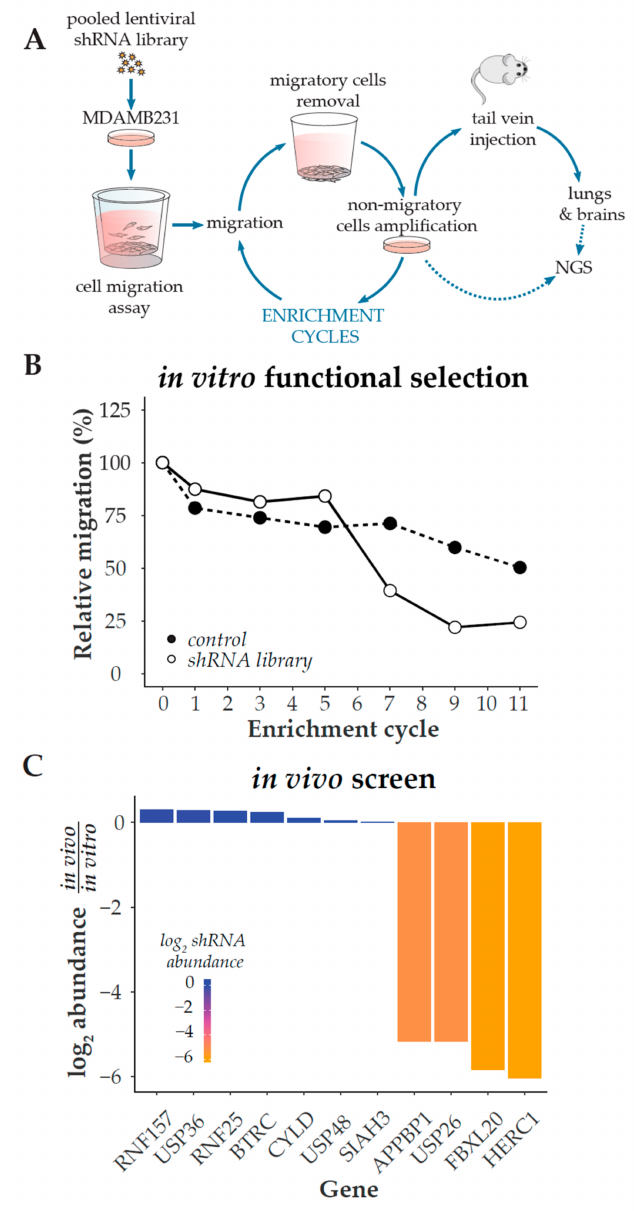
Figure 1. shRNA-based selection of positive regulators of cell migration. ( A ) Overview of the selection procedure. The production and infection of an ubiquitylation-related lentiviral shRNA library are described in Methods. Two weeks after lentiviral infection and selection, MDA-MB-231 cells were seeded onto Boyden chamber inserts and allowed to migrate across the porous membrane at 37 ◦ C for 24 h in order to select cells with a decreased migration phenotype. Migrating cells were removed and non-migrating cells were collected by trypsin treatment from the inserts upper compartment and cultivated for one week. Cells were then reseeded onto Boyden chamber culture inserts for a subsequent round of selection; this procedure was repeated until cells lost 75% of their initial migratory potential. This non-migratory population of cells was then inoculated through tail vein injection into NOD/SCID mice, and primary cultures were generated after two months from lung and brain tissues. shRNAs were retrieved by PCR from the in vitro and in vitro/vivo-selected cells, and then identified by Next Generation Sequencing (NGS). ( B ) Boyden chamber assay was used every other enrichment cycle to determine the relative percentage of migratory cells and monitor the selection process. ( C ) shRNAs abundance after the in vivo selection, relative to their abundance in the in vitro-selected non-migratory